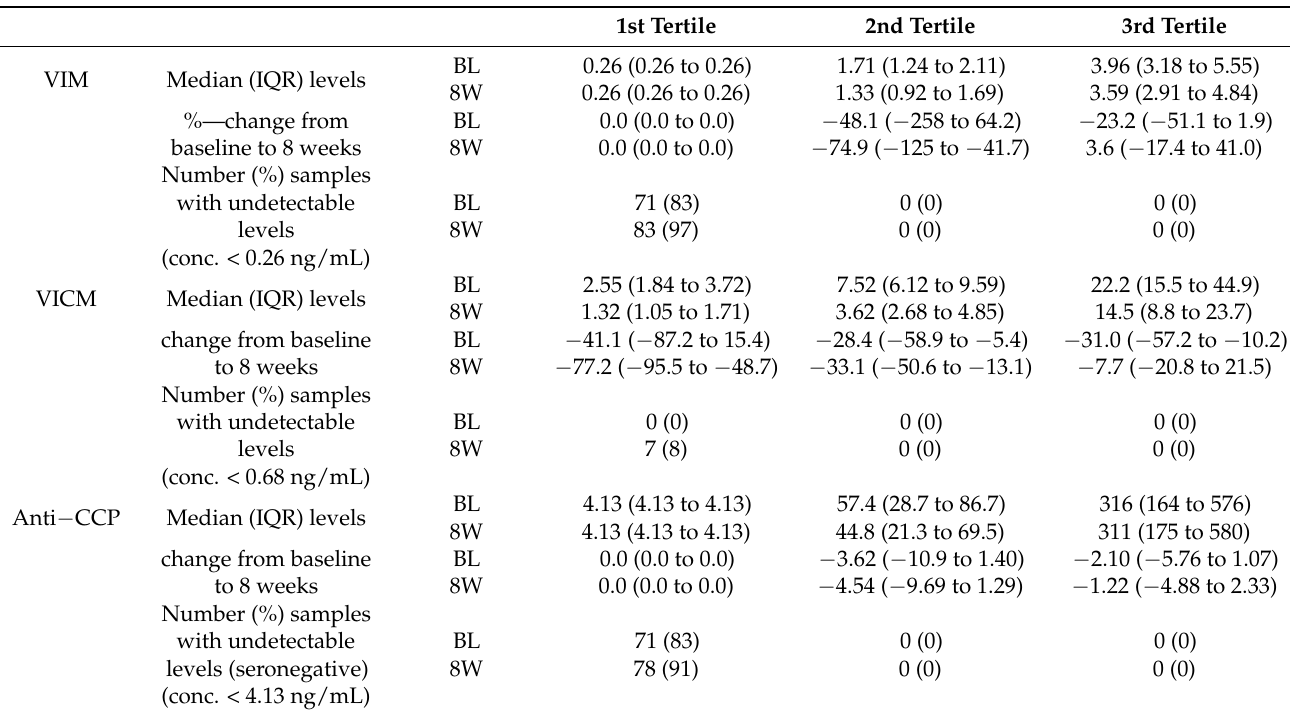
Table A3. Summary data for Table